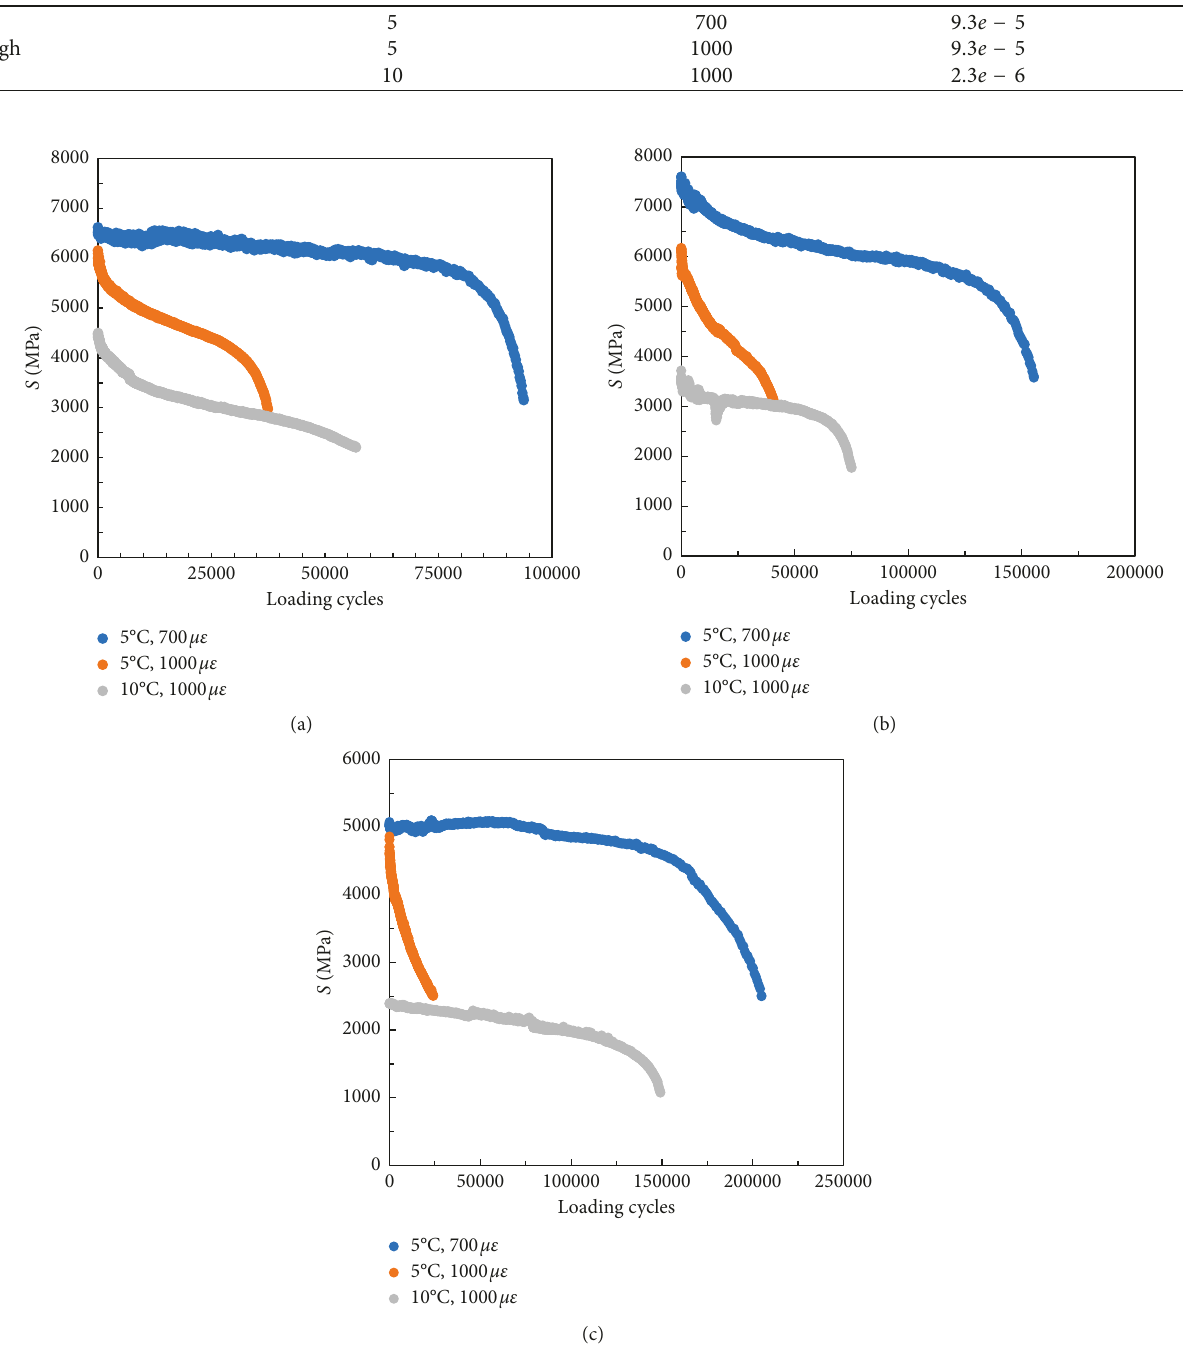
Figure 9: Influences of the temperatures and strain levels on the fatigue performance of asphalt mortar: (a) low asphalt content; (b) moderate asphalt content; (c) high asphalt content.